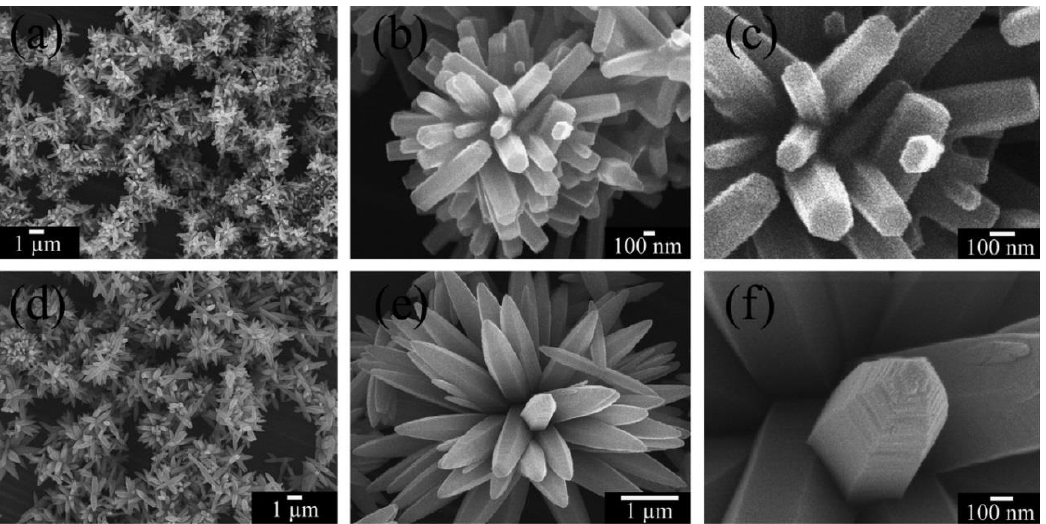
Figure 21. SEM images of ZnO synthesised in solutions containing Zn(NO 3 ) 2 ·6H 2 O